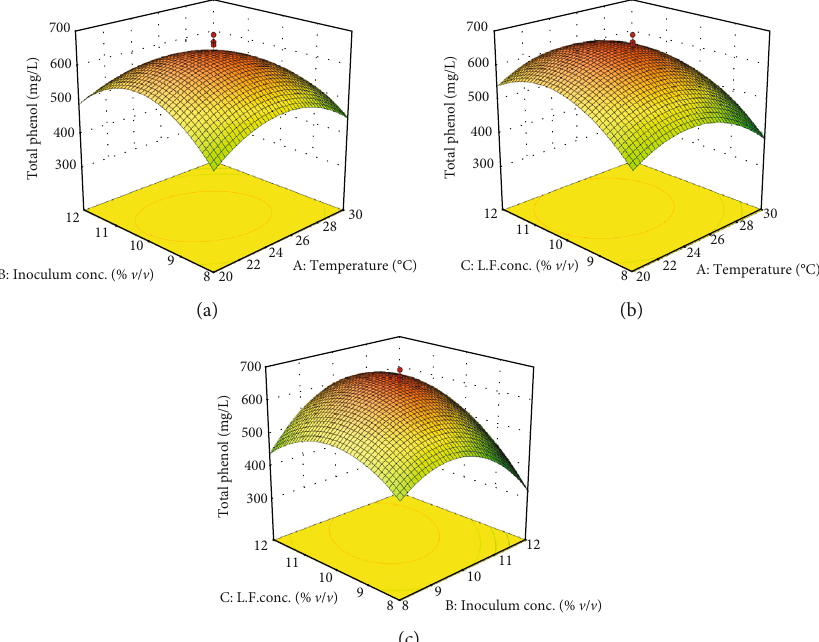
Figure 2: Response surface and contour plots for the e ff ect of inoculum concentration (a, Lantana camarafruit concentration = 10 %v / v ) and temperature; Lantana camara fruit concentration (b, inoculum concentration = 10 %v / v ) and temperature; Lantana camara fruit concentration (c, temperature = 25 ° C ) and inoculum concentration on the total phenol content of the produced